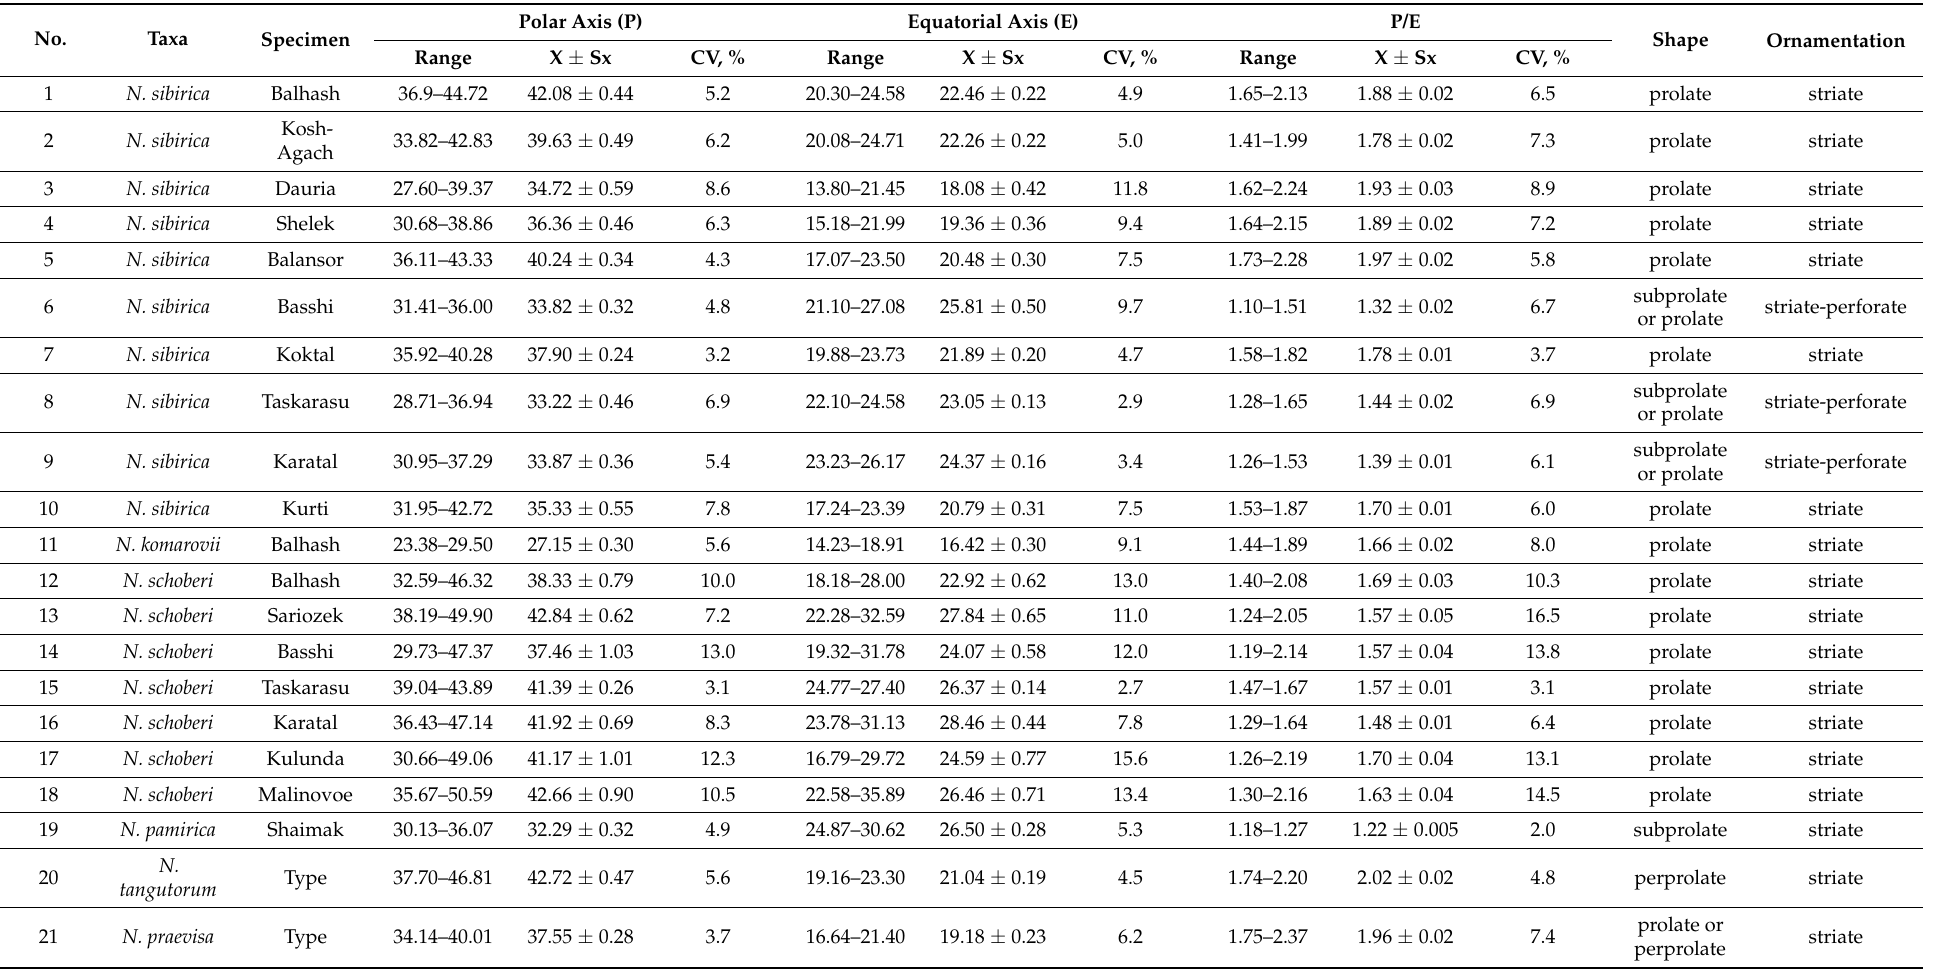
Table 1. Measurements (in µ m) of pollen grains of Nitraria . The data are presented as the mean (X), standard error (Sx), and the coefficient of variation (CV,